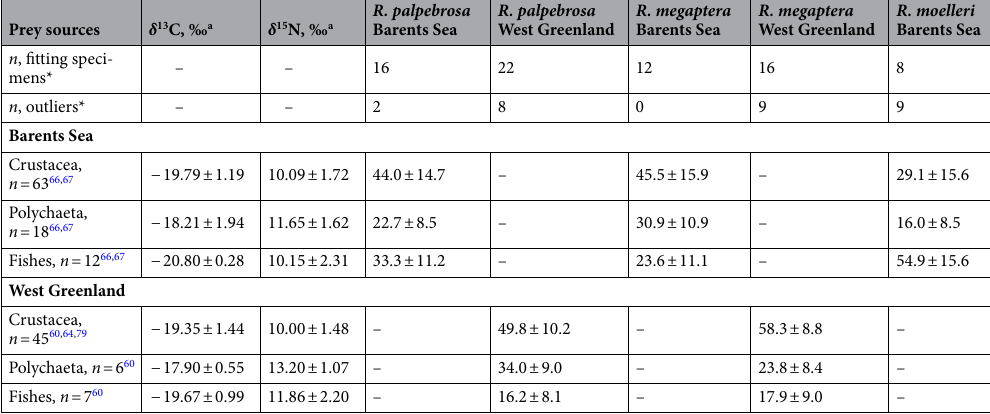
palpebrosa had the highest variation of all values, R. megaptera had the lowest variation of δ 15 N and TL, and R. moelleri had the lowest variation of δ 13 C (Table 2). No significant ontogenetic increase of δ 13 C values was found in any of the studied species (Table 2, Supplementary Table S5). Significant ontogenetic decrease of δ 13 C values was found in R. megaptera in the Barents Sea and East Greenland, and in R. moelleri in the Barents Sea (Table 2, Supplementary Table S5). As expected, values of δ 15 N and TLs showed significant ontogenetic increase in all species and areas (except for R. megaptera in East Greenland) (Table 2, Supplementary Table S5). The largest size group was the most different from the smallest and second-most from middle one, with no differences between the smallest and middle-sized groups (Table 2, Supplementary Tables S2–S5). A westward significant increase of δ 13 C values was found in R. palpebros a (i.e. Barents Sea–West Greenland: U = 81, p = 0.0002) and in R. moelleri (i.e. Kara Sea–Barents Sea: U = 71, p = 0.0005) (Table 2, Supplementary Tables S3, S4, S6). Values of δ 15 N, as well as TLs, showed no geographic differences, with the exceptions of R. megaptera which had significantly higher TL in the Barents Sea, than in East Greenland ( U = 14, p = 0.0293), and R. moelleri which had significantly higher TL in the Barents Sea, than in the Kara Sea ( U = 115, p = 0.0429) (Table 2, Supplementary Tables S3, S4, S6). No differences between sexes were found in either δ 13 C or δ 15 N values or TLs in any species (Table 2, Supplementary Tables S3, S4, S6). Overall (i.e. using all the specimens), Rossia moelleri had significantly lower δ 13 C values than R. palpebrosa and R. megaptera ( U = 64, p < 0.0001 vs. R. palpebrosa and U = 38, p < 0.0001 vs. R. megaptera ), and in all areas and ontogenetic stages (Table 2, Supplementary Tables S2–S4, S7). Values of δ 15 N and TLs in R. moelleri were significantly higher than in R. palpebrosa and R. megaptera , overall ( δ 15 N: U = 673, p = 0.0179 vs. R. palpebrosa and U = 432, p < 0.0001 vs. R. megaptera ; TL: U = 644, p = 0.0086 vs. R. palpebrosa and U = 420.5, p < 0.0001 vs. R. megaptera ) and in all the studied areas (Table 2, Supplementary Tables S2–S4, S7). In terms of size groups’ comparison among species, only very large R. moelleri had significantly higher values than large R. palpebrosa and R. megaptera (Table 2, Supplementary Tables S2–S4, S7). Isotopic niches. No differences in niche width were found between sexes in R. palpebrosa ; both sexes showed a large overlap (Supplementary Table S8). However, females in R. megaptera and R. moelleri had signifi- cantly wider niche than males, with males having larger overlap with females (> 95%) than vice versa (52–55%): females had medium overlap with males (Supplementary Table S8). Significant ontogenetic decrease in niche width was found in R. moelleri , and gradual (not significant) ontogenetic decrease and increase in R. palpebrosa and R. megaptera (Fig. 1, Supplementary Table S9). Larger size groups overlapped more with smaller ones in R. palpebrosa and R. moelleri , with the opposite pattern in R. megaptera (Fig. 1, Supplementary Table S9). Large overlap was found between small and medium R. palpebrosa , and consequently in small–medium–large R. meg- aptera (Fig. 1, Supplementary Table S9). Differences in niche width among species were found only in the Barents Sea (Fig. 1, Table 3). In the Barents Sea, R. megaptera had significantly narrower niche than R. palpebrosa and R. moelleri (Fig. 1, Table 3). Rossia moelleri had only small overlap with R. palpebrosa and R. megaptera in the Barents Sea, and no overlap with them